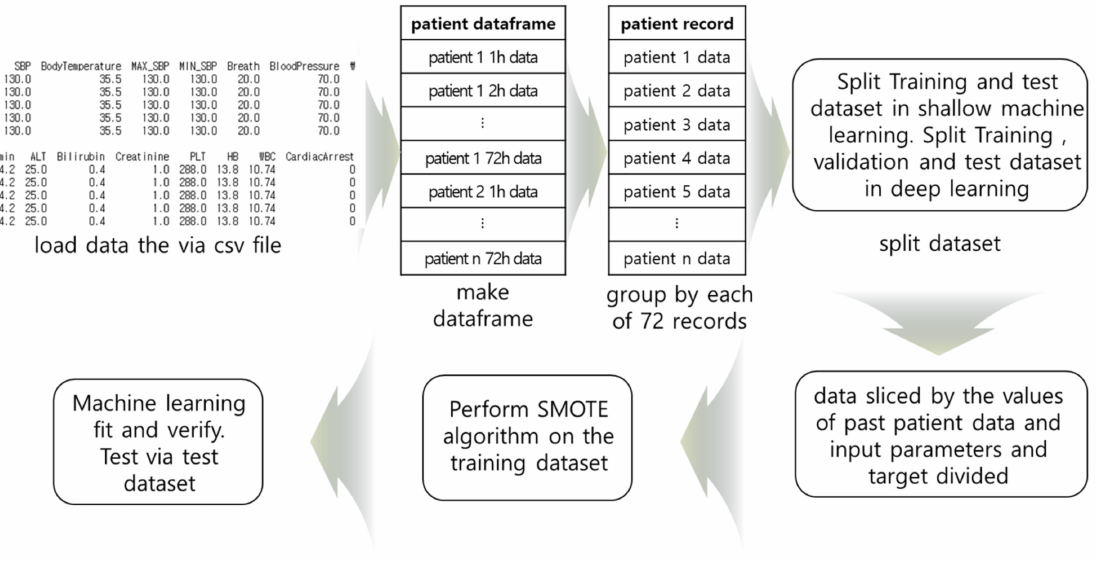
Figure 1. The workflow of cardiac arrest